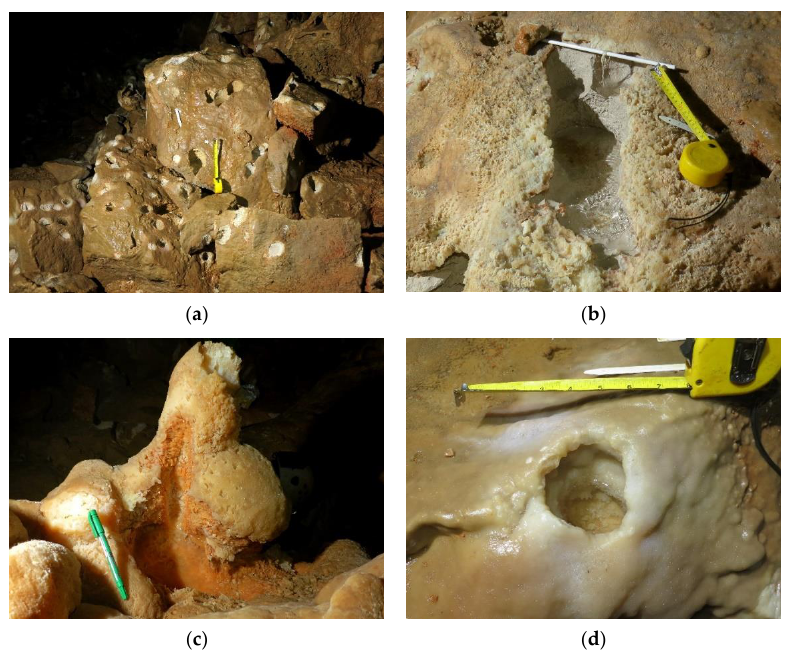
Figure 3. Photos of a selection of corrosion features. ( a ) Boulders in the Red Hall, covered by a thin flowstone crust and corrosion cups. ( b ) Wide shallow RD1 cup with heavily corroded surroundings due to splashing. ( c ) An example of a stalagmite that is heavily corroded by several drips. ( d ) RD2 cup covered in flowstone and containing broken crystals. A yellow tape measure with a length of 10 cm or a 14-cm-long pen was used as a